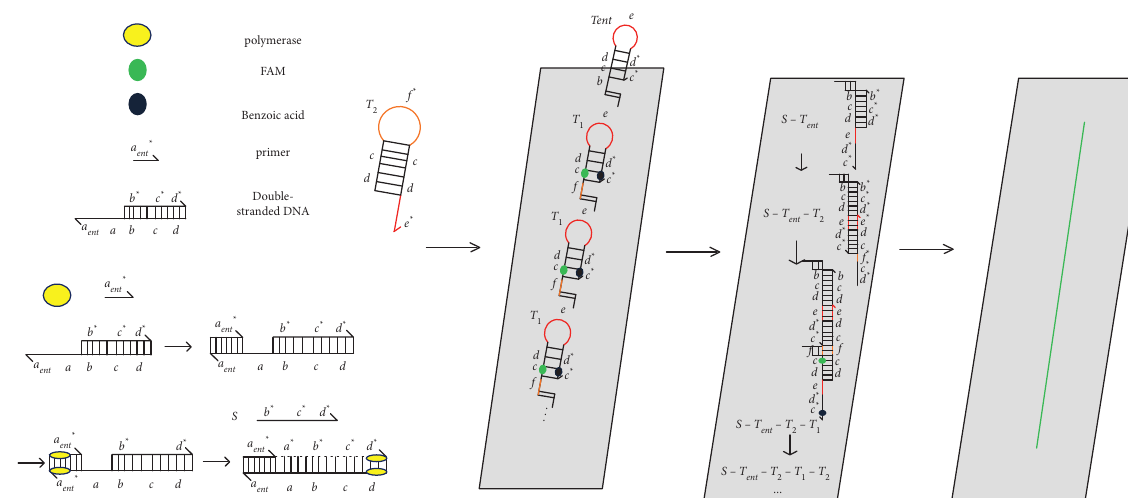
Figure 8: The case of AND gate input (1,